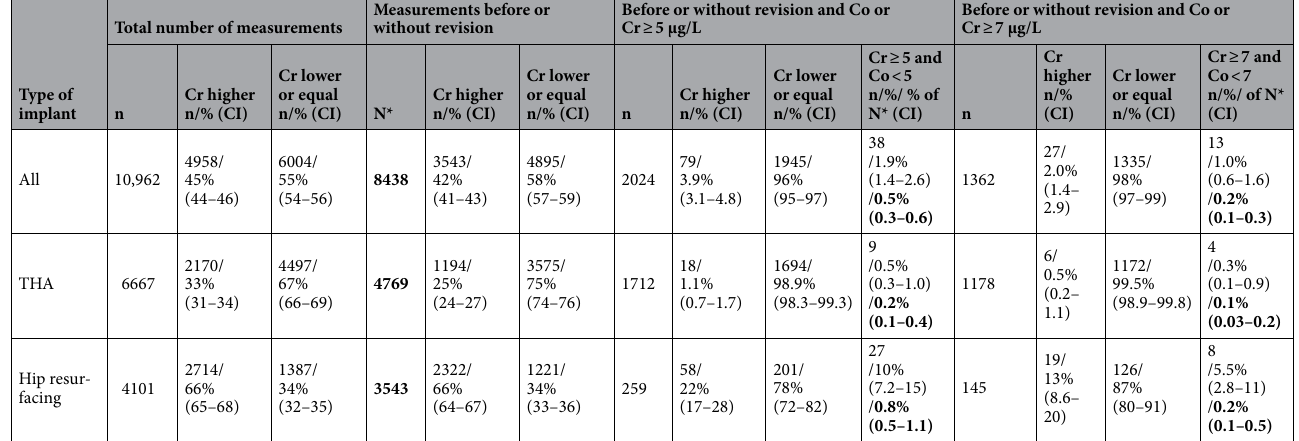
Table 2. Percentages of paired measurements with higher whole blood chromium value compared to cobalt. Co, cobalt; Cr, chromium; CI, 95% confidence interval; THA, total hip arthroplasty. In columns “measurements before or without revision” the Co and Cr measurements performed after a revision surgery are excluded because it is known that whole blood Cr may remain elevated longer than Co after revision surgery 17